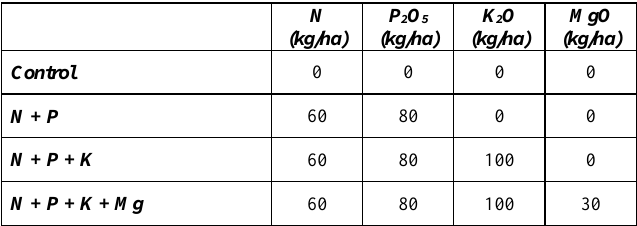
Yields of control trees were lower in both years (5.9-7.2 kg/tree), than in the case of the fertilized trees (7.8-11.3 kg/tree) ( Figure 1 ). In 2016, NP treatment showed the highest fruit amount (11.3 kg/tree), followed by NPK (9.5 kg/tree) and Table 2 . Applied treatments and doses of N, P, K and Mg fertilizers NPKMg treatment (9.0 kg/tree). In 2017 differences among the in the experimental sweet cherry orchard. fertilized trees were more balanced (8.3-9.0 kg/tree).